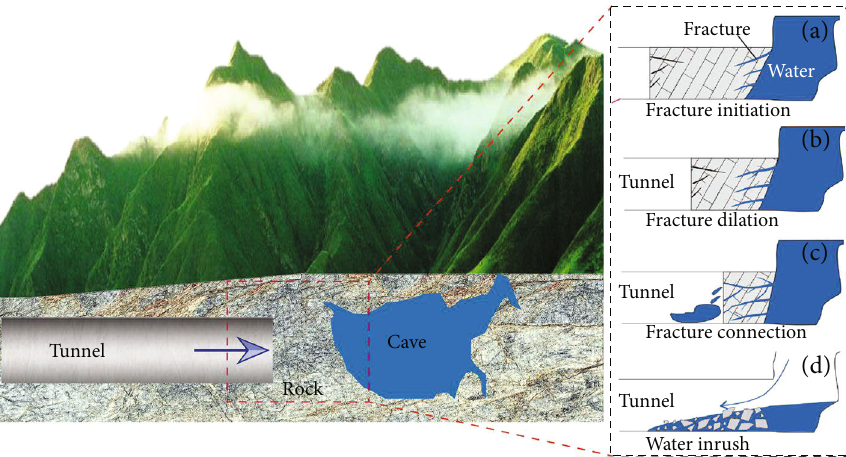
Figure 1: Water inrush process diagram. (a) Fracture initiation. (b) Fracture dilation. (c) Fracture network formation and leakage. (d) Water inrush